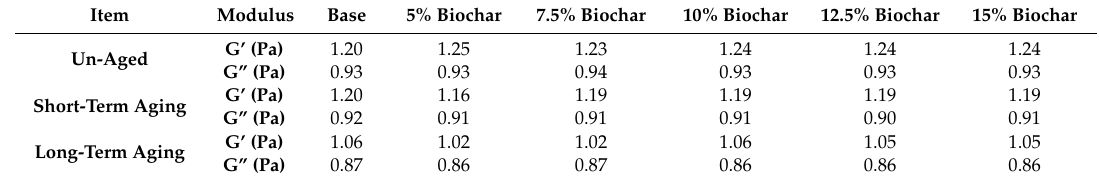
Table 5. Slope of dynamic shear modulus and frequency curve of asphalt binder before and after